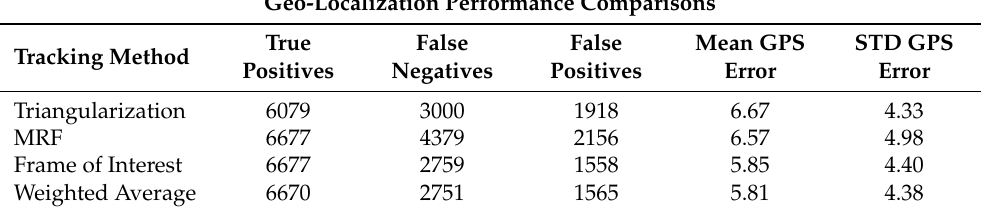
Table 5. Performance comparison using different methods to reduce tracklets into sign detections. For each method, we count the total true positives, false negatives, and false postives compared to the ground truth for the full dataset. The mean GPS error indicates the mean absolute distance between a true positive sign prediction and its corresponding ground truth in meters. The STD GPS error indicates the standard deviation of the distribution of true positive GPS